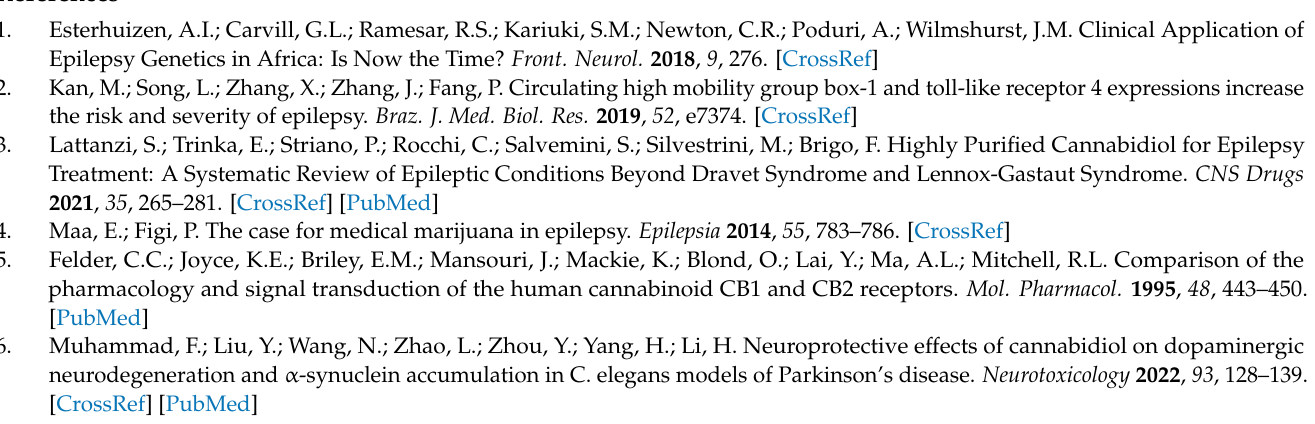
Table S2: Differential metabolites between PTZ group and WT group; Table S3 Differential metabolites between CBD group and PTZ group; Figure S1: The correlation network between PTZ group and WT group; Table S1: DEGs of PTZ group of WT group